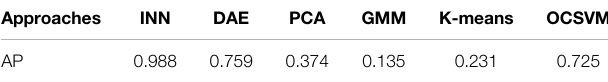
TABLE 3 | APs of different approaches with real-world